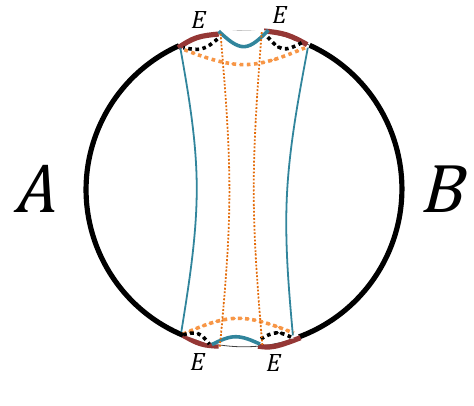
Figure 10 . A proof of I ( A : B j E ) (cid:21) I ( A : B ) for an extension (cid:26) ABE , where E is on the original boundary [32]. The di(cid:11)erence I ( A : B j E ) (cid:0) I ( A : B ) is given by the area of dashed orange codimension-2 surfaces minus that of solid blue ones, which is clearly non-negative by the minimal property of